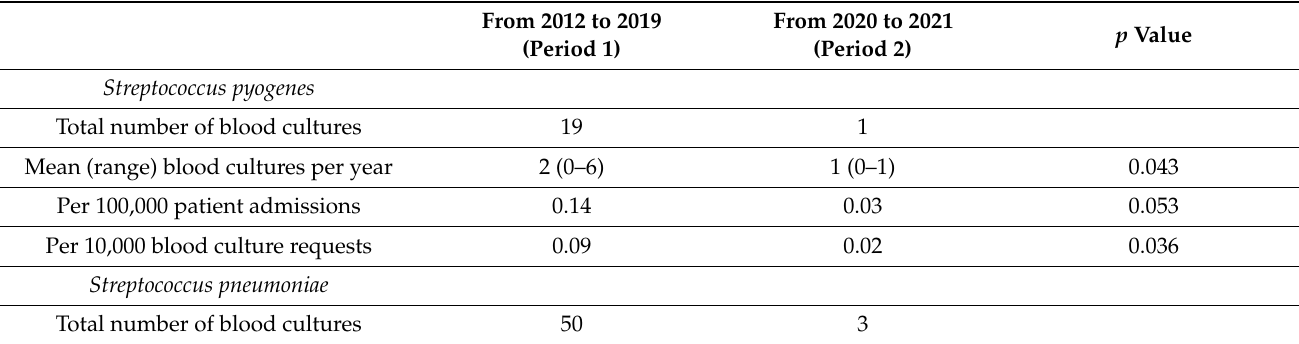
Table 3. Hospital-onset bacteremia of selected pathogens before and during the COVID-19 pandemic in Hong Kong a